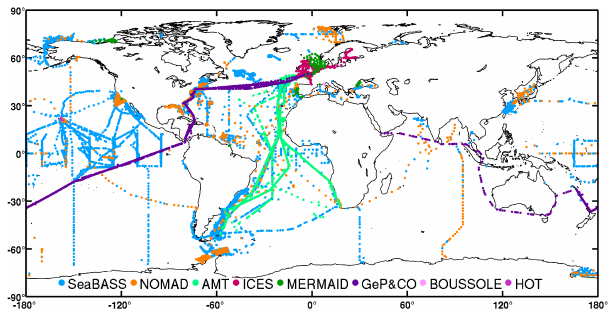
Figure 9. Global distribution of chlorophyll a concentration per dataset in the final table. All chlorophyll data were considered, but for a given station HPLC data were selected if available.